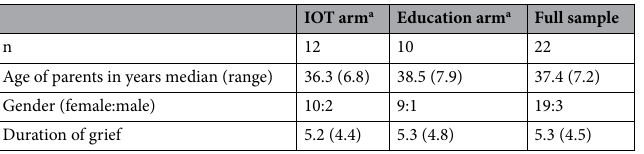
Table 1. Cohort descriptive statistics. IOT insight oriented psychotherapy. a Mean (sd), or count.